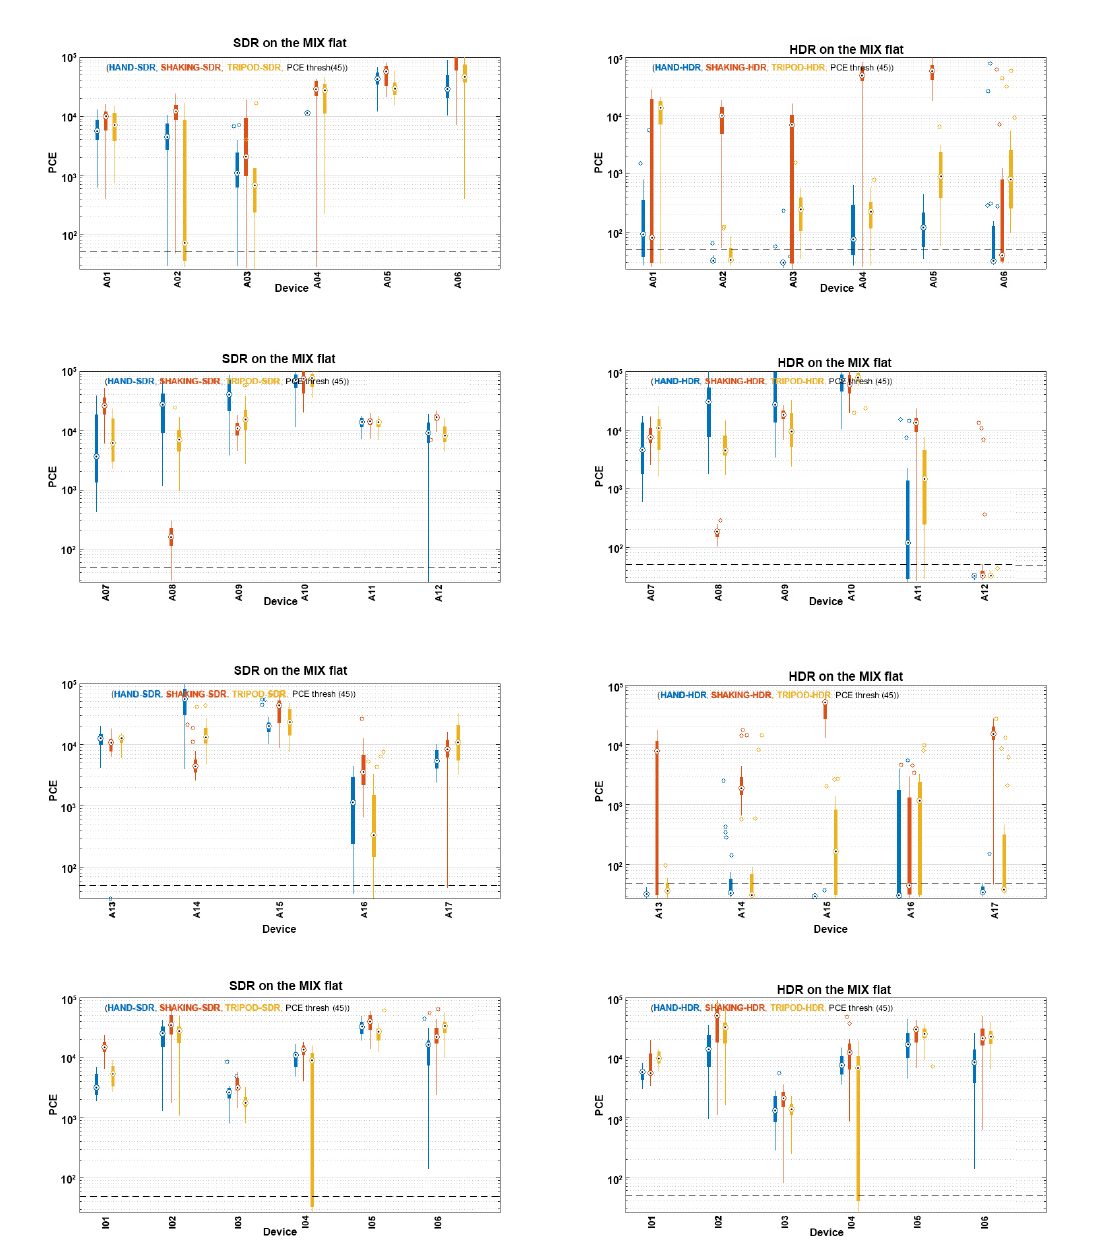
Figure 9. PCE values obtained by SDR and HDR images when compared with a flat MIX-based